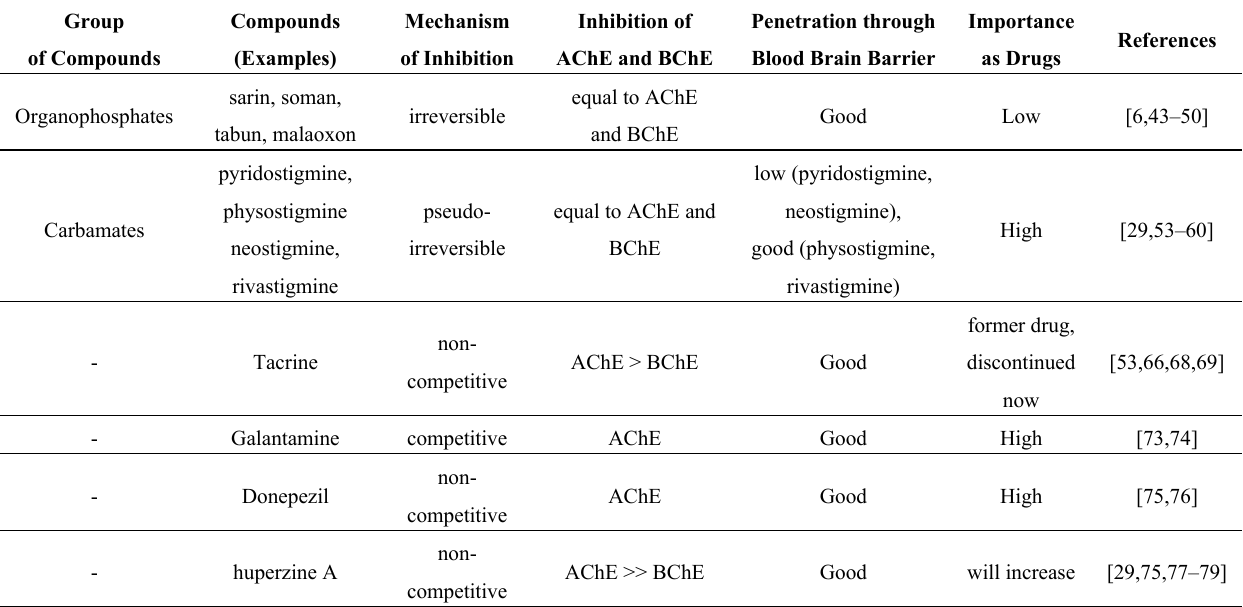
Table 1. Summarization of facts about cholinesterases’ inhibitors.